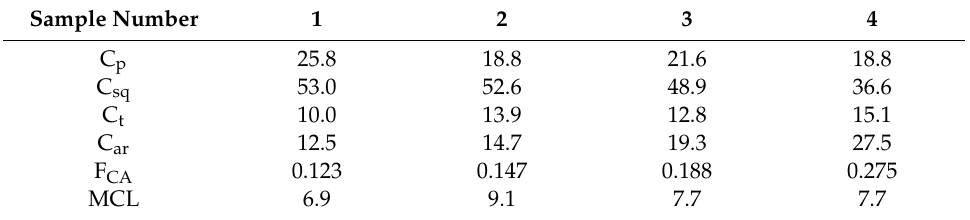
Table 4. Molar fractions (%) of primary (C p ), secondary and quaternary (C sq ), tertiary (C t ), aromatic (C ar ) groups, aromaticity factor (F CA ), and mean chain length (MCL) of aliphatic hydrocarbons based on 13 C NMR spectra of samples 1–4.